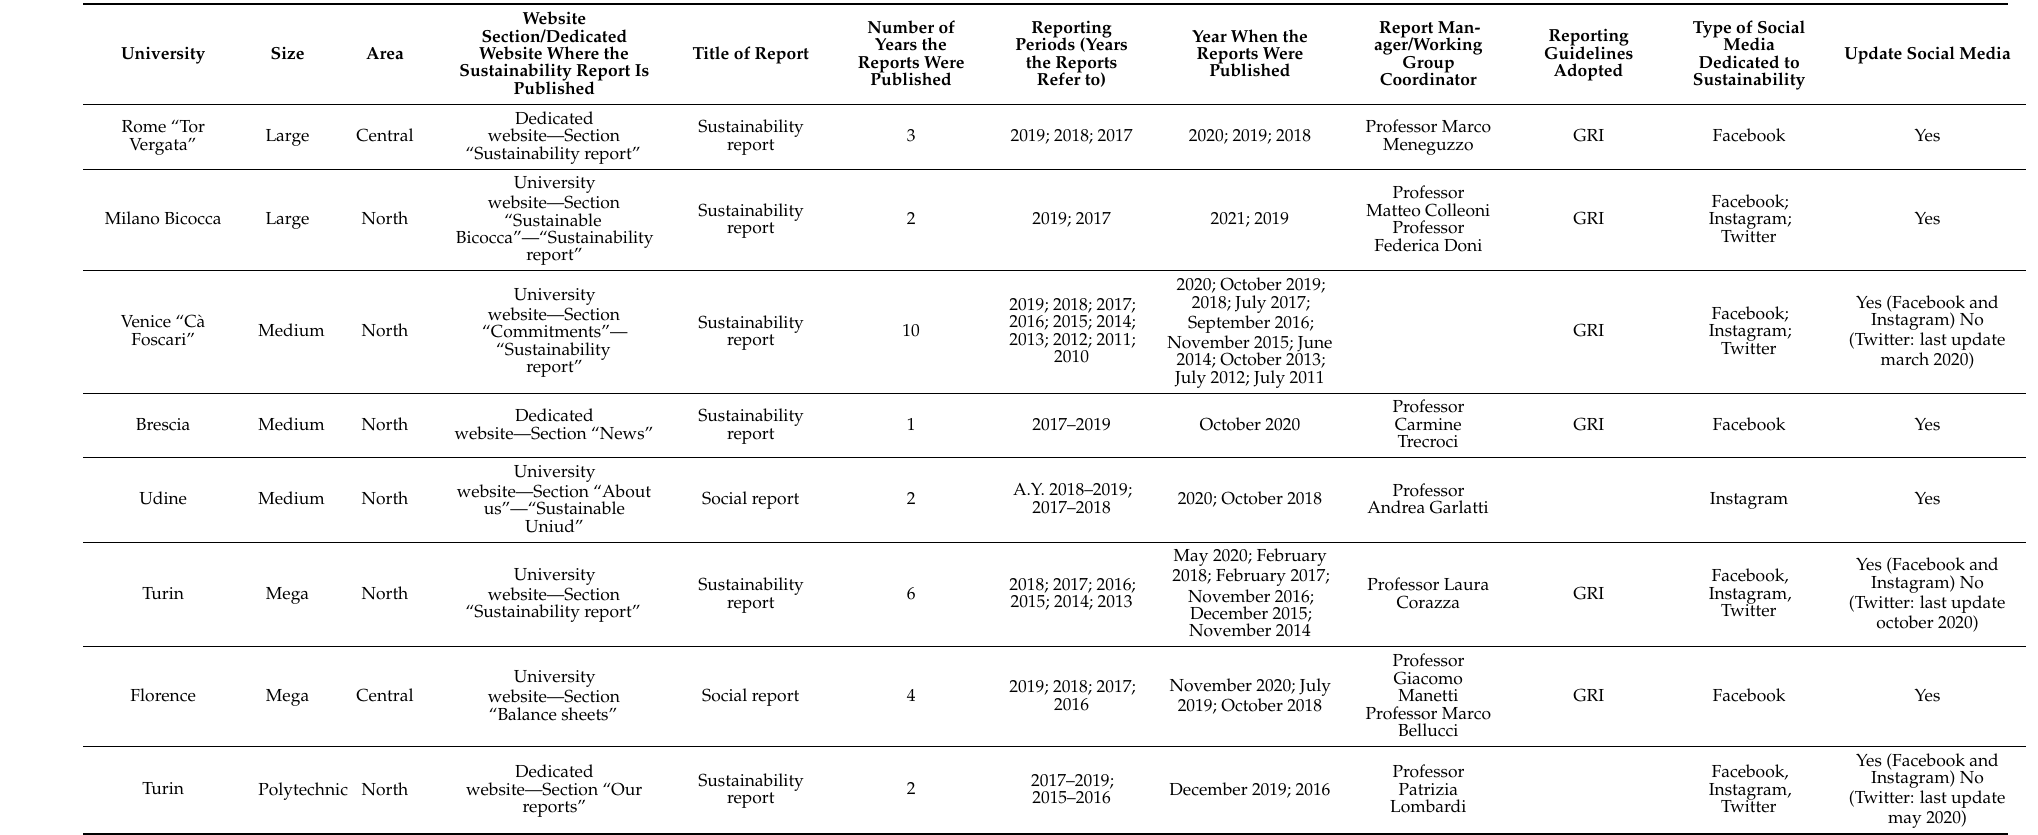
Table 1. Summary of characteristics and content of sustainable reports and social